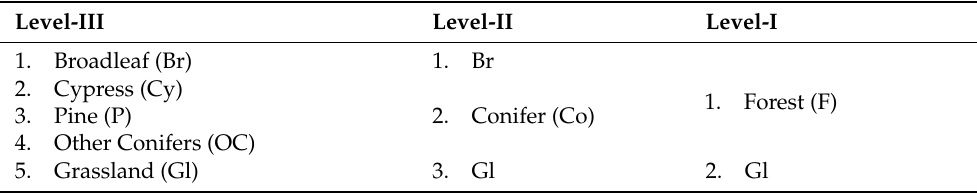
Table 1. Hierarchical classification of the Level-III, -II, and -I LULC